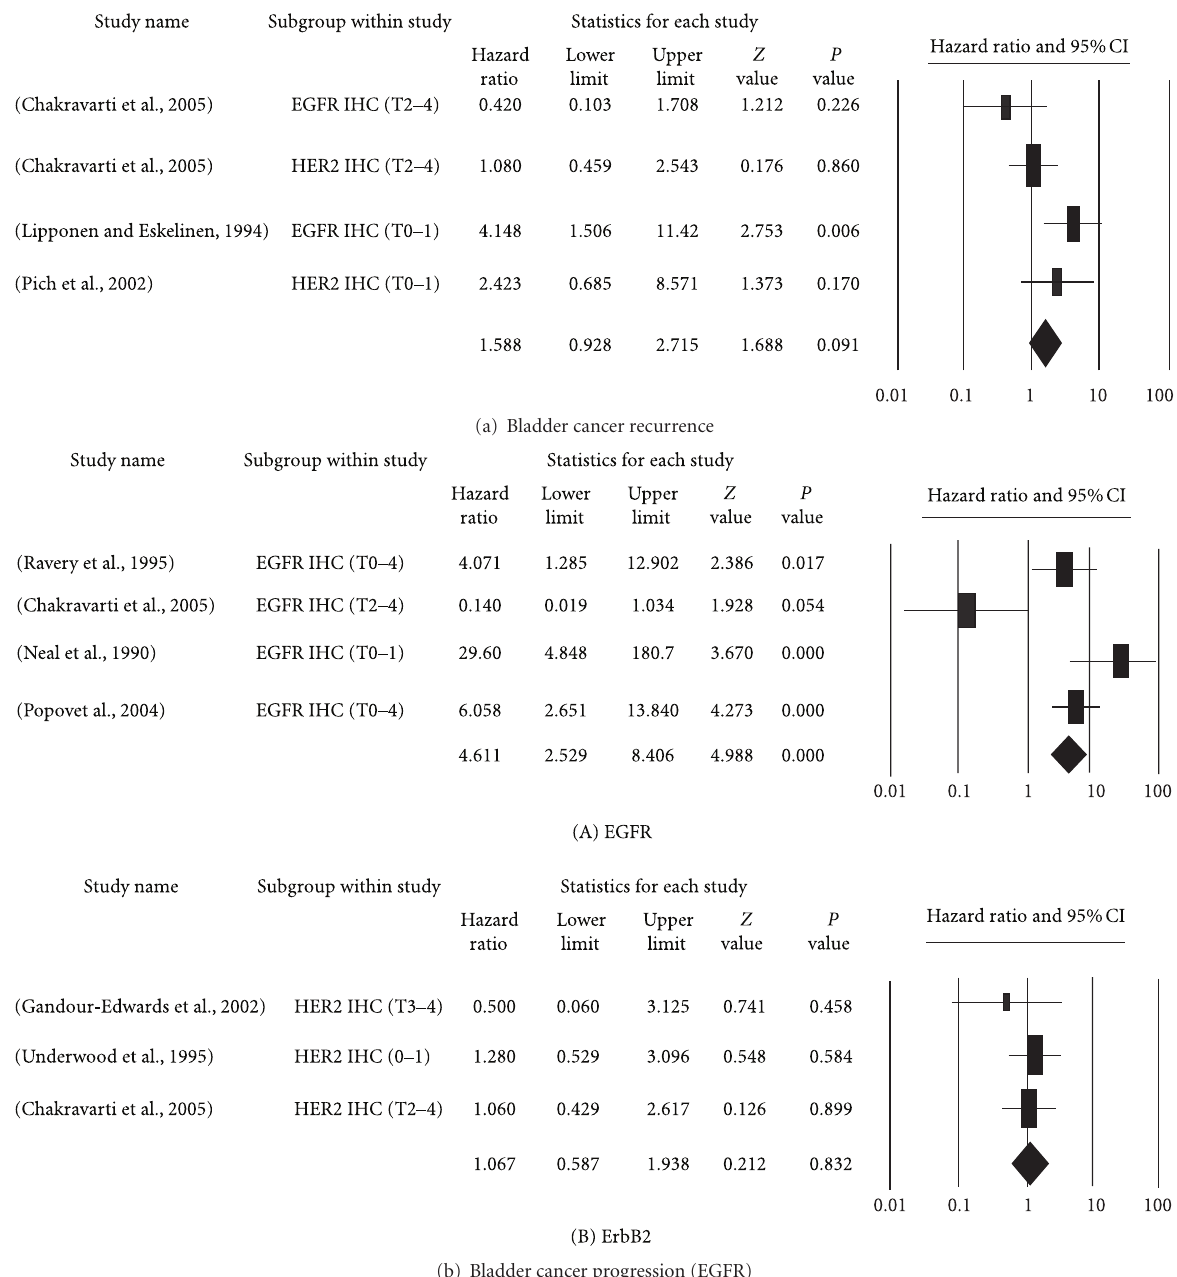
Figure 1: Forest plots of studies on the prognostic significance of EGFR and ErbB2 overexpression in bladder cancer. (a) The e ff ect on recurrence. (b) The e ff ect of EGFR (A) or ErbB2 (B) on progression. Hazard ratios and 95% (confidence intervals) CIs for patients with either EGFR- or ErbB2-positive